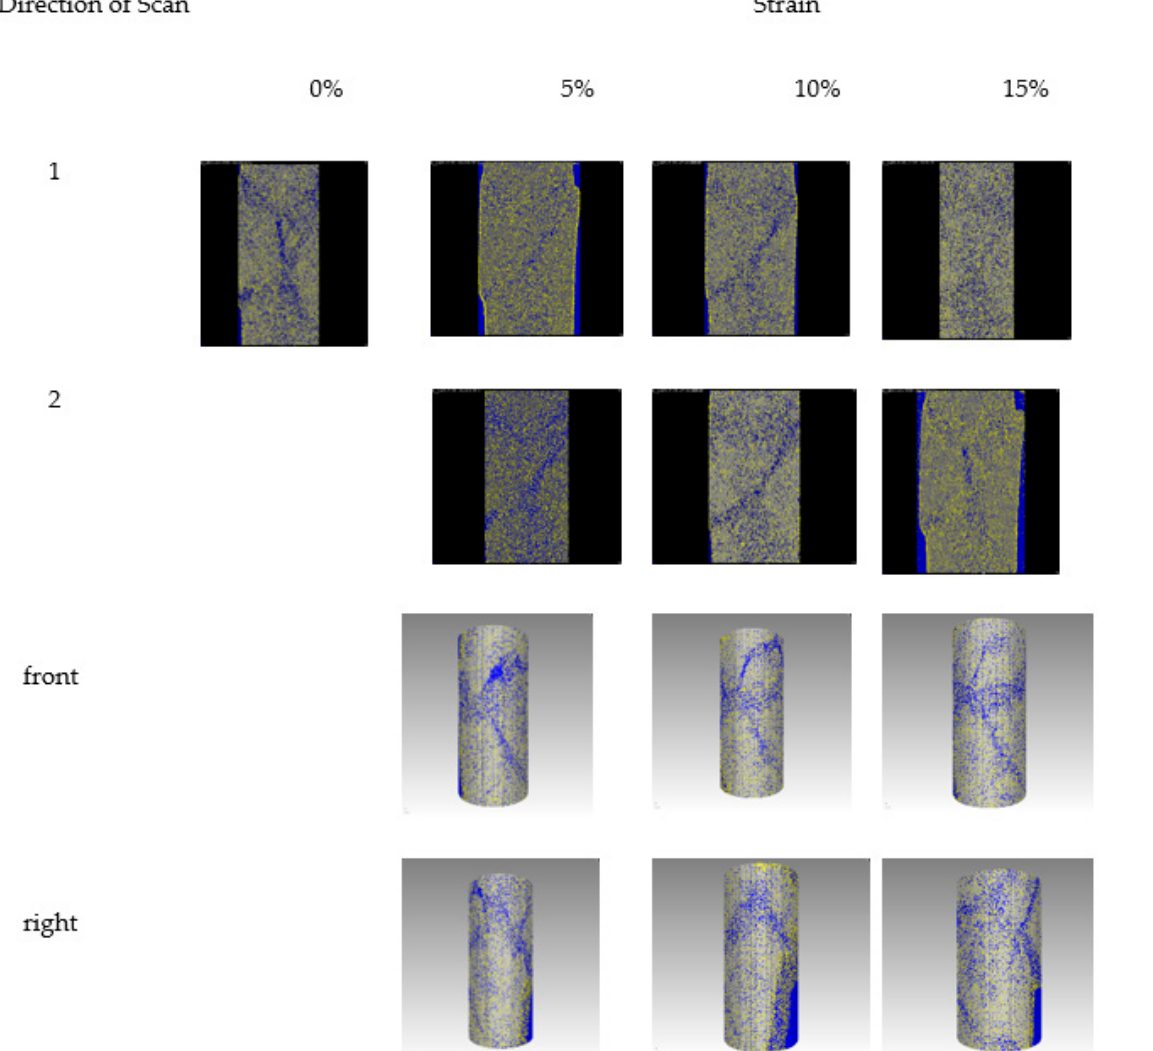
Figure 7. CT images with strain in different scan direction ( S h = 38%). These images are obtained in the same way as those in Figure 6, ‘front’/’right’ and ‘1’/‘2’ mean the different directions of CT scan to the samples. The color of white indicates sand; the yellow indicates hydrate; the blue indicates gas.